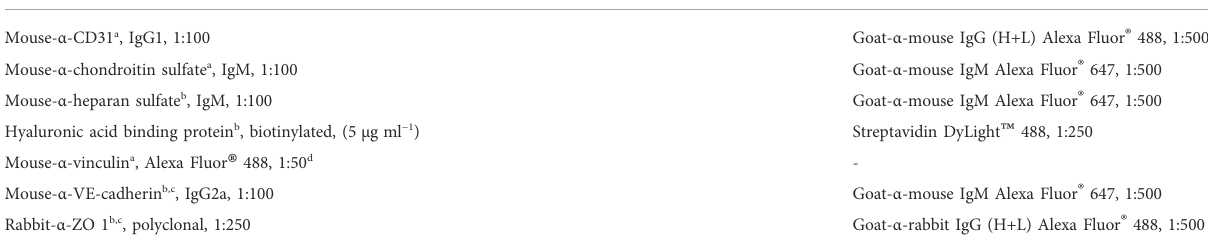
TABLE 1 Conditions for immuno fl uorescence staining. Primary